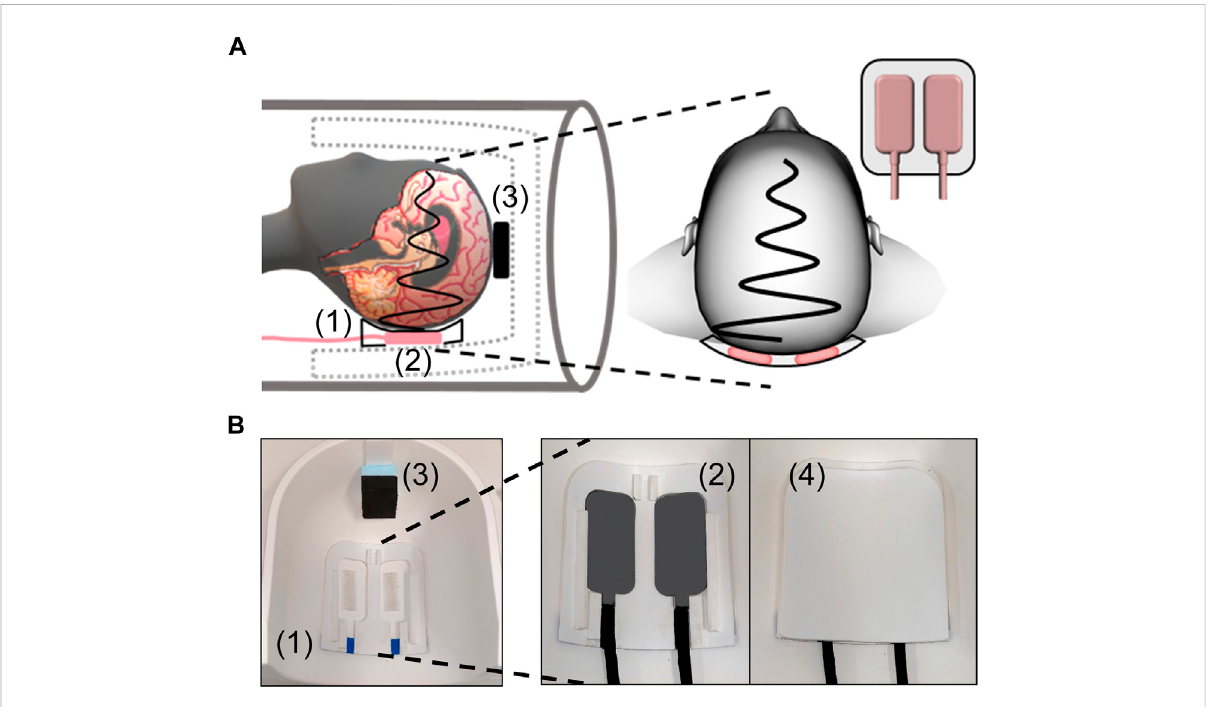
FIGURE 1 MRE experimental setup. (A) Schematic of positioning the head within the head coil with a placeholder (1) for two actuators (2) underneath the headandaspacer(3)atthetopofthehead.Thecloseviewshowsthelateralpositioningofthetwoactuatorsinsidetheplaceholder. (B) Photographs of placeholder (1) and spacer (3) in the head coil while actuators (2) inside the placeholder and the transmission plate (4) covering the actuators are shown in